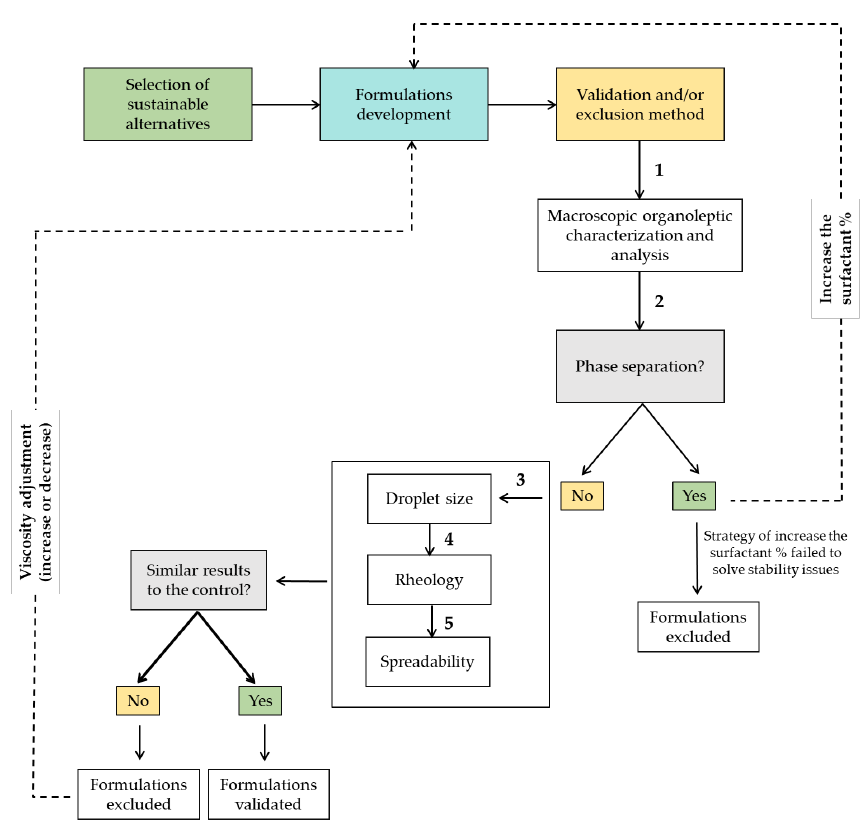
Figure 5. Validation and/or exclusion diagram considering the physicochemical features of O/W emulsions.